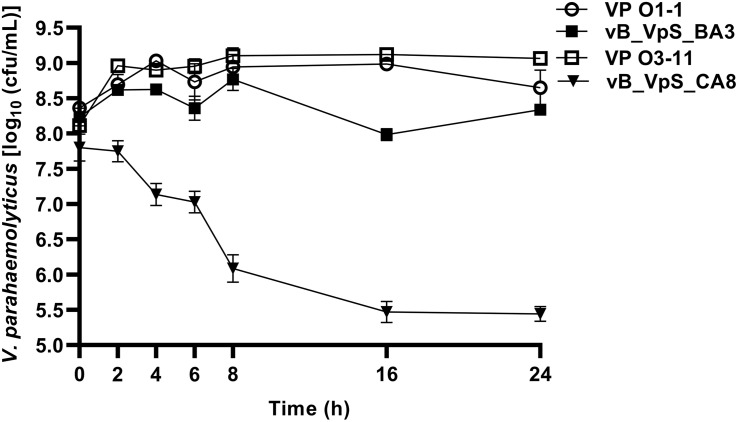
Bacterial growth reduction. Reduction in the exponential growth phase of VP O1-1 and VP O3-11 by phage BA3 and CA8 at an approximate MOI of 0.1. The given values are the means of three determinations.